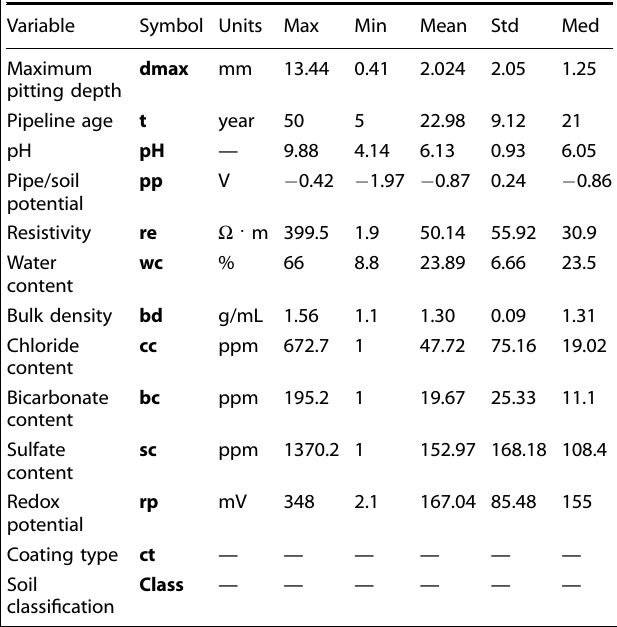
Table 5. Basic descriptive statistics of